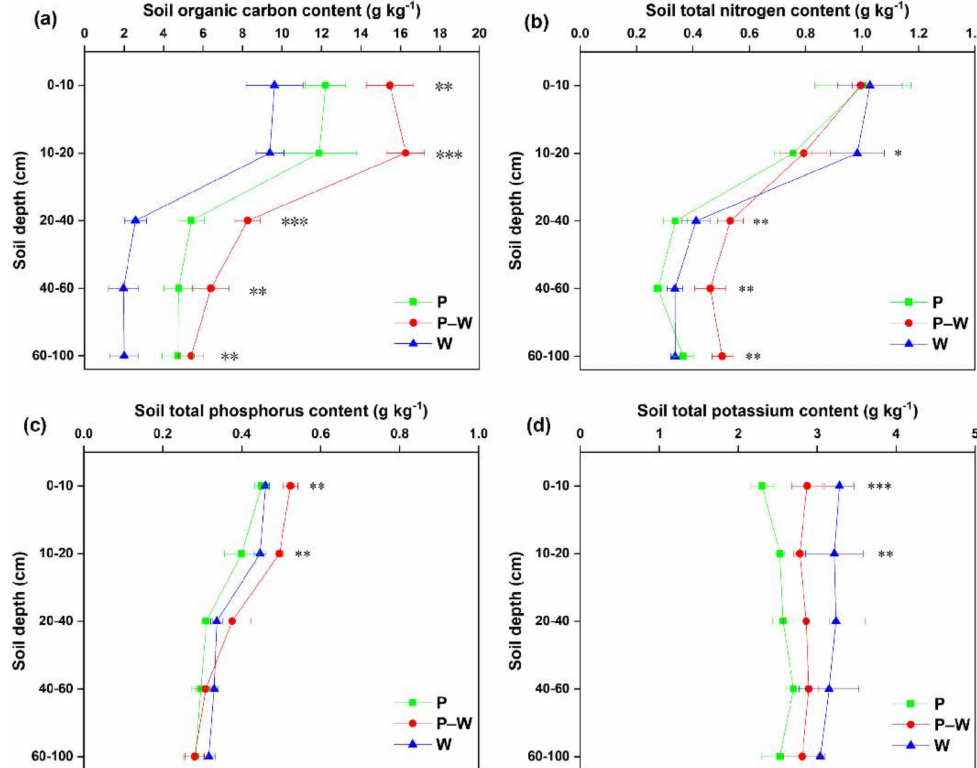
Figure 3. Vertical variations of SOC ( a ), TN ( b ), TP ( c ) and TK ( d ) contents in different land-use types. The asterisks indicate significant differences among the three land-use types within the same soil layer, * p < 0.05, ** p < 0.01, and *** p < 0.001. P, poplar plantation system; P–W, wheat field system after deforestation of a poplar plantation; W, wheat field